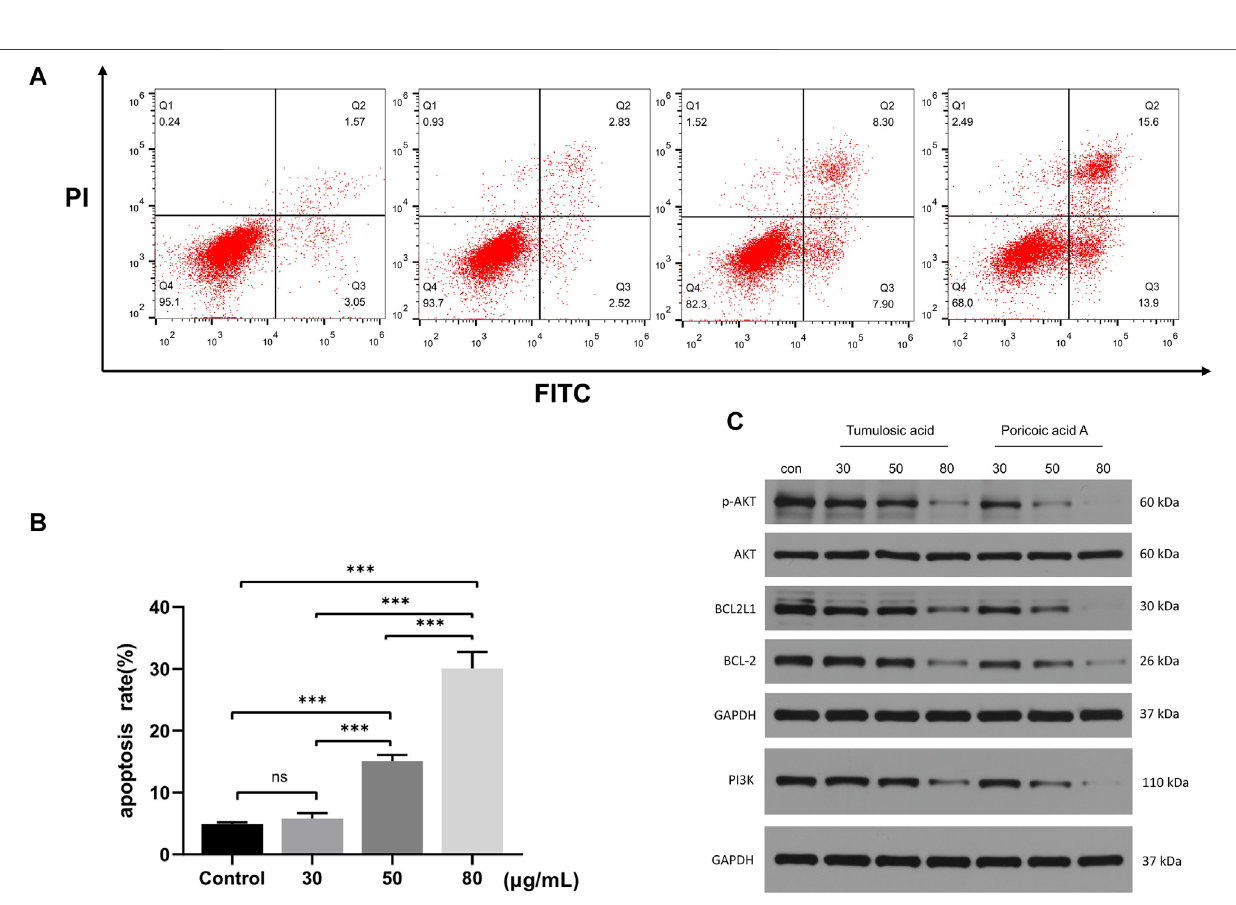
Frontiers in Pharmacology |